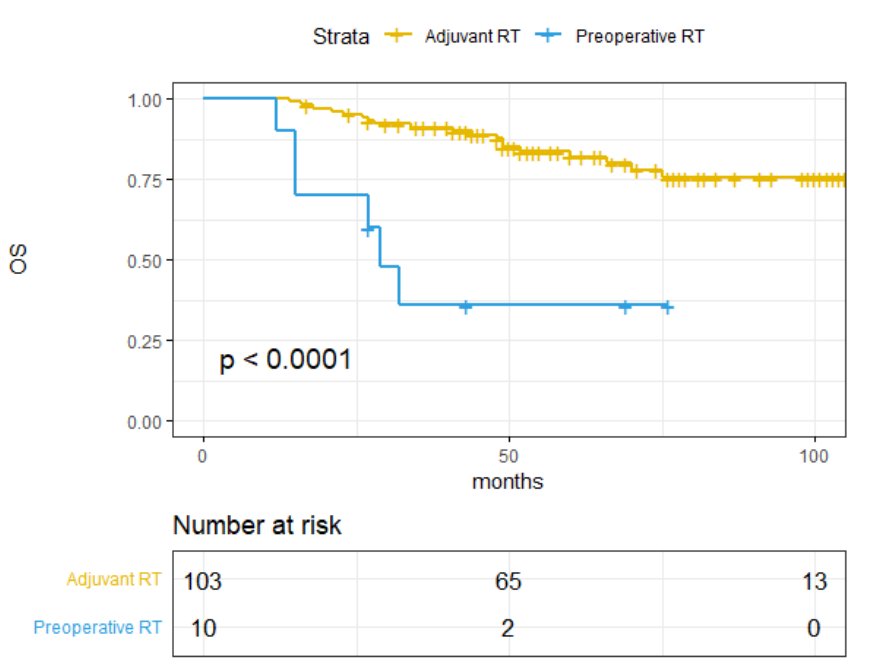
Figure A2. DFS with adjuvant radiotherapy (5-y DFS: 71.8% [63.1–81.6%]) vs. with preoperative radiotherapy (30.0% [11.6–77.3%]).